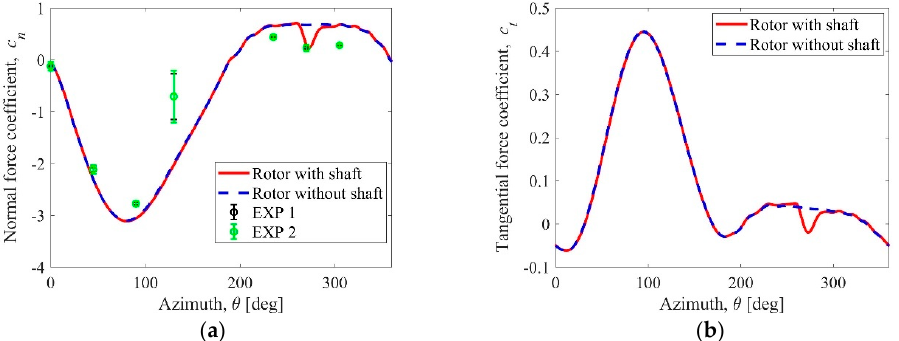
Figure 5. Aerodynamic blade loads. ( a ) Normal force component; ( b ) tangential force component.